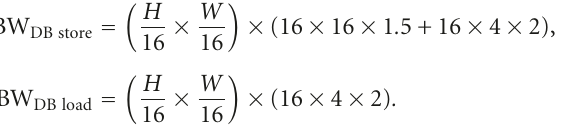
Figure 16: The pixels to be written twice for deblocking filter.